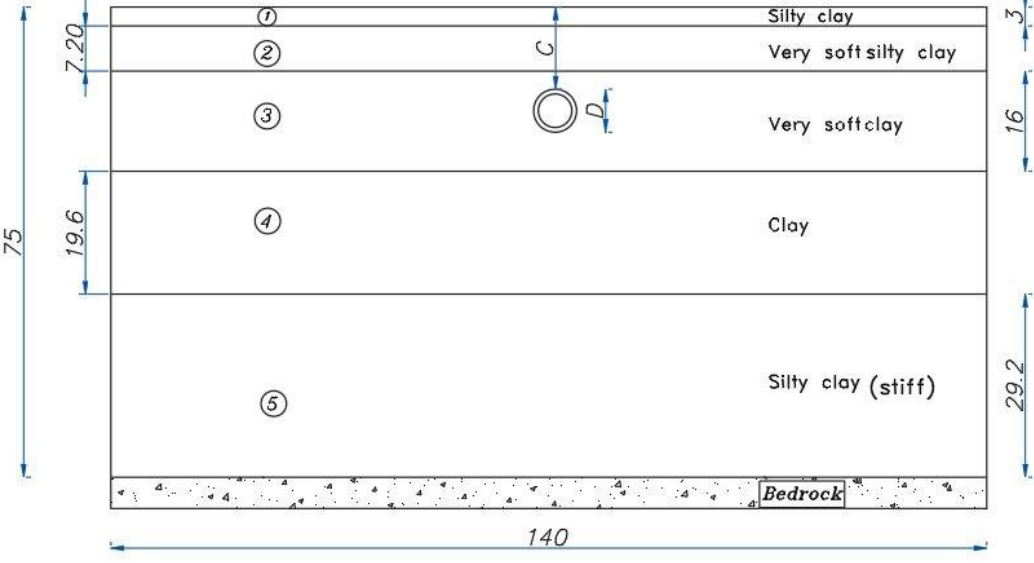
Table 2. Properties of the clay